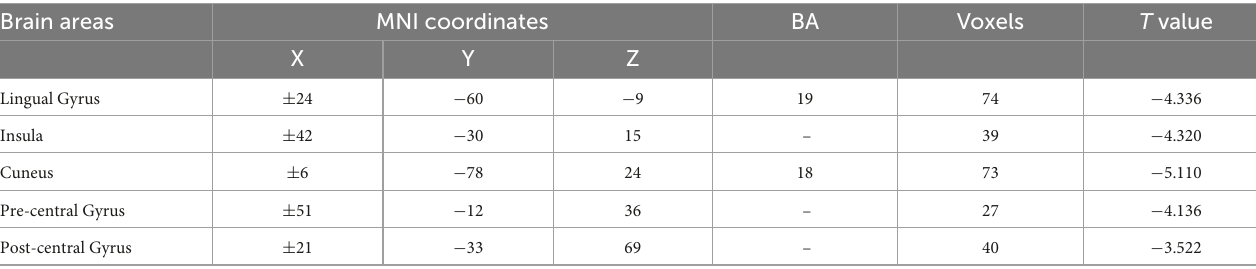
TABLE 2 Differences in voxel-mirrored homotopic connectivity (VMHC) between two group. Brain areas